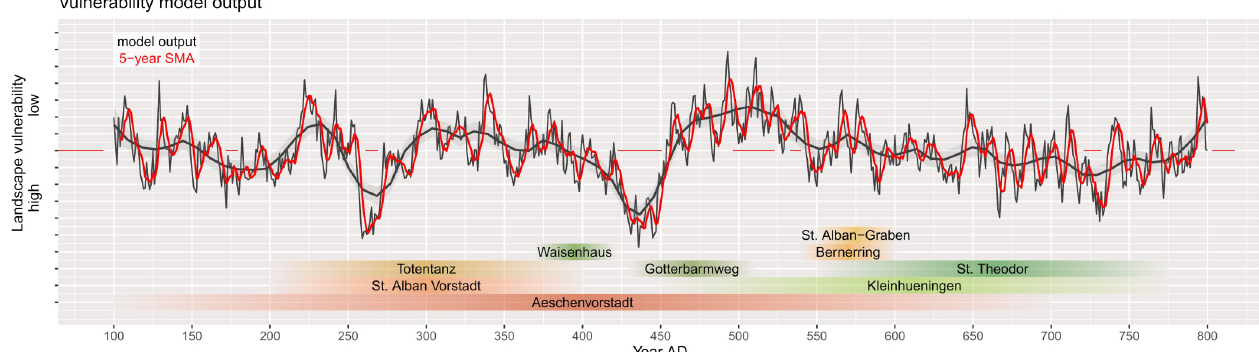
Fig 9. Model output and occupation of the late antique and early medieval graveyards at Basel. The black line represents the annual average model output (landscape vulnerability) with a loess smoothing parameter of 0.1. The red curve is a previous 5-year simple moving average (SMA). Graveyards are highlighted in green (northern bank of the river Rhine and red (southern bank of the river